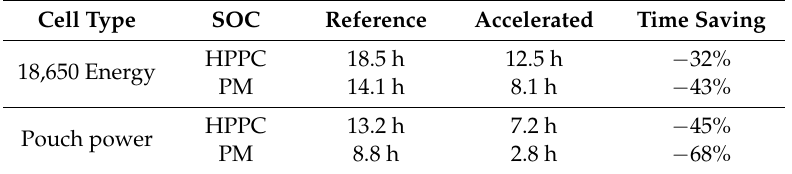
Table 5. Experiment time (excluding thermal